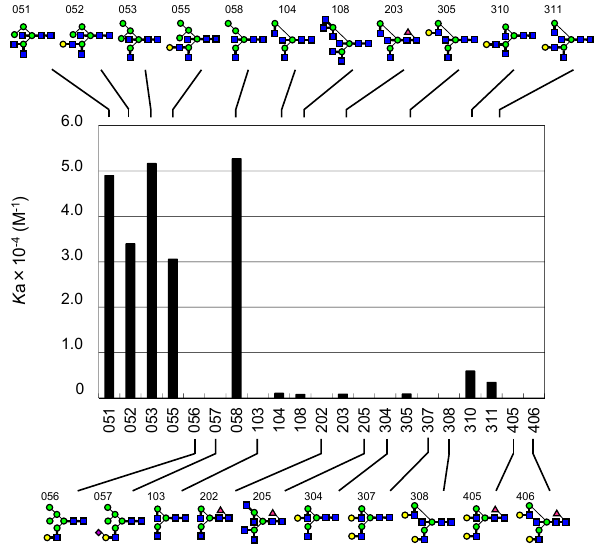
Figure 6. Featured specificity of WGA for hybrid-type N -glycans containing bisecting GlcNAc. A bar graph of affinity constant ( K a ) in relation to the presence or absence of bisecting GlcNAc was made. Bound and non-bound glycan structures are shown at the top and the bottom of the graph, respectively.